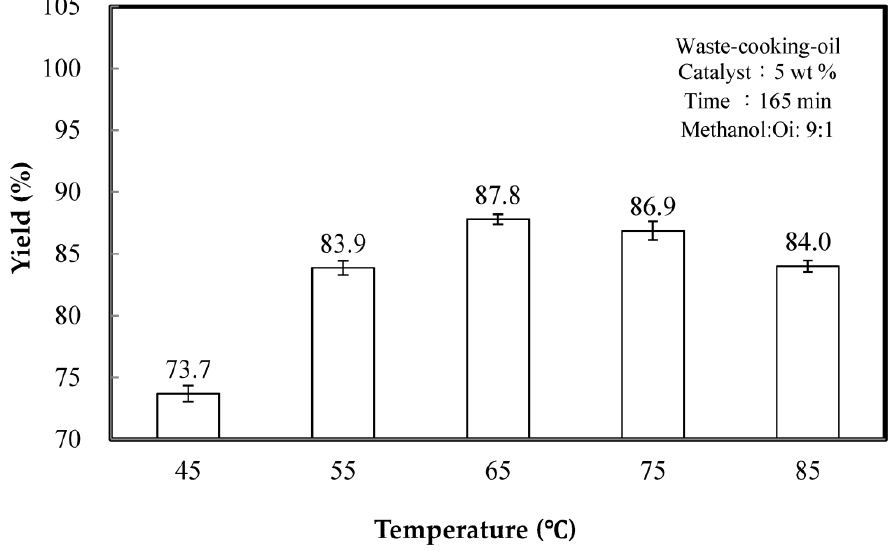
Figure 6. Effects of microwave temperature.